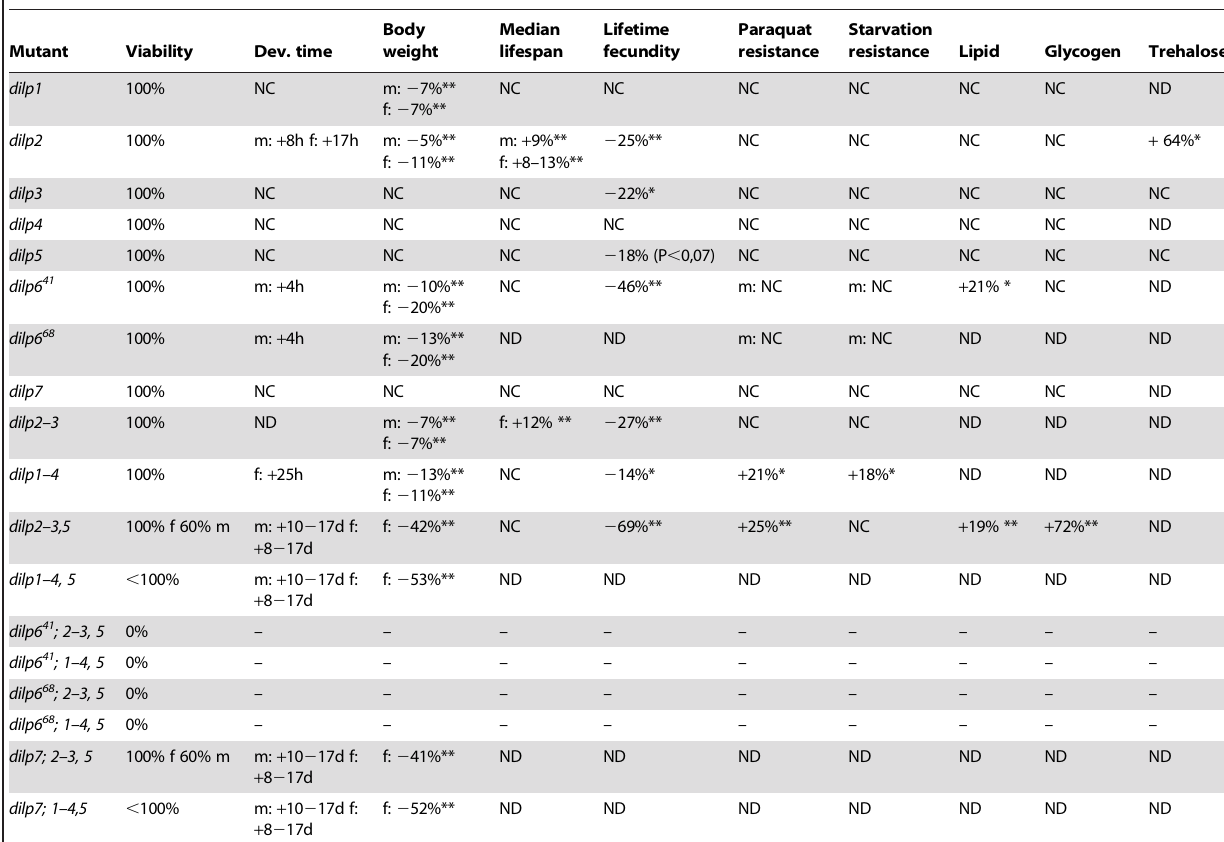
Table 1. Systematic analysis of DILP